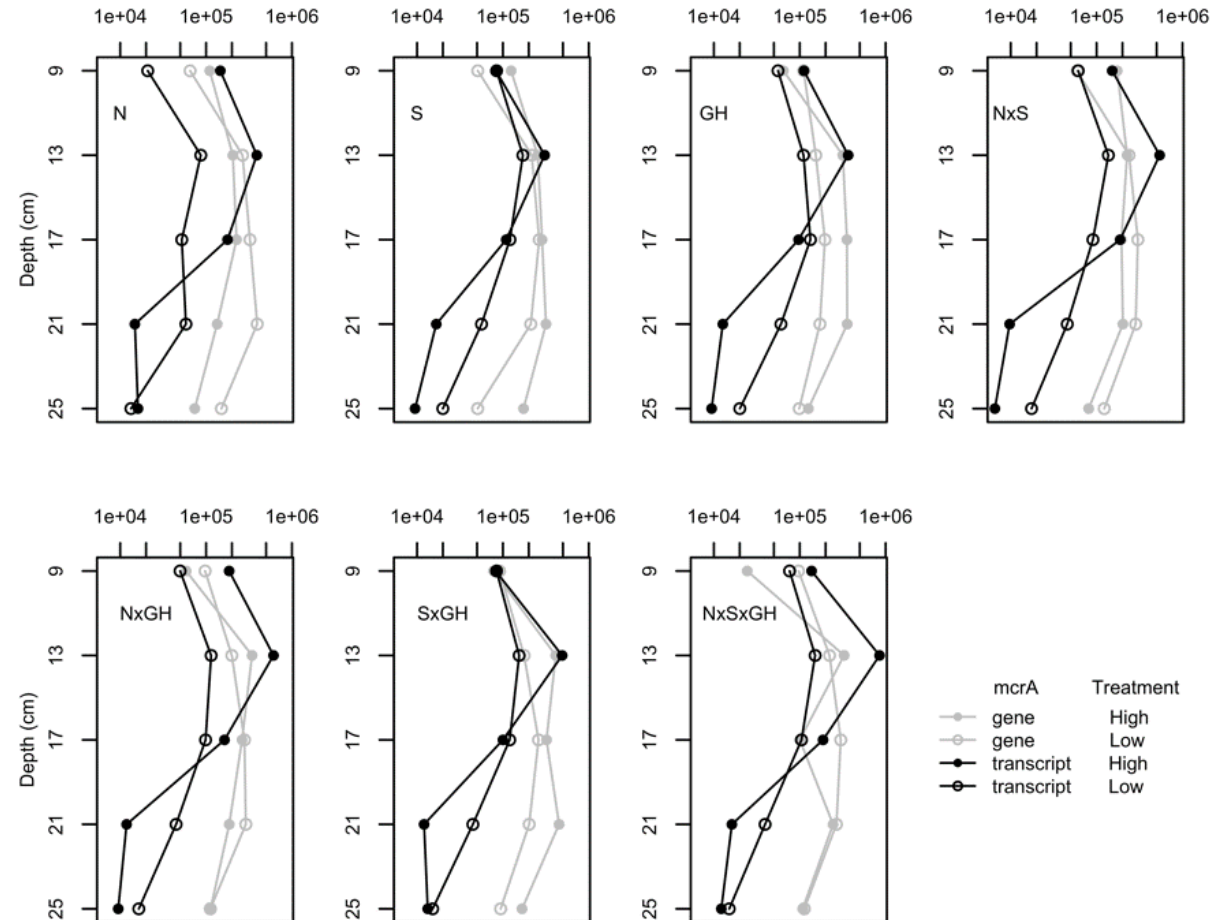
Figure 2. Depth profiles, per treatment effect, of the abundance of mcr A gene copies and transcripts per gram of soil (note the logarithmic scales on horizontal axes). ‘Low’ refers to the low (ambient) treatment level and ‘High’ to treatments involving N (30 kg ha -1 yr -1 ) or S (20 kg ha -1 yr -1 ) amendment or warming (GH), singly and in combination. Number of replicates: for main effects, n = 8; for two-way interaction effects, n = 4; and for three-way interaction effects, n =